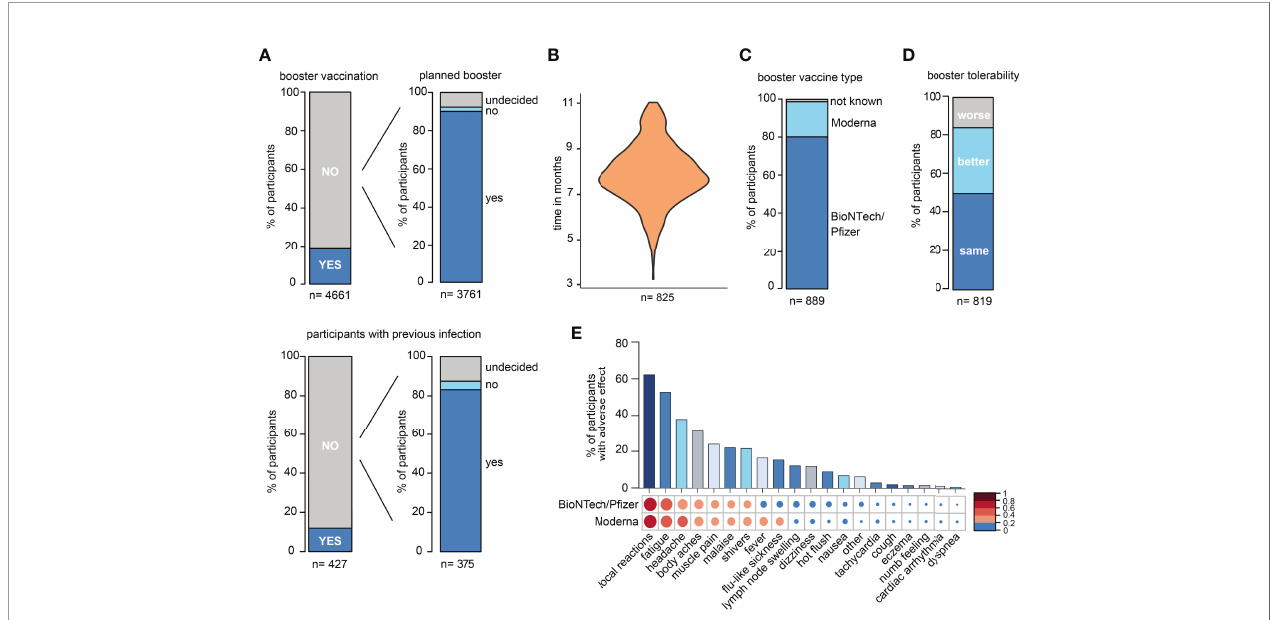
FIGURE 1 | Survey data from the DigiHero SARS-CoV-2 booster vaccination module. (A) Statistics of participants with prior or planned third SARS-CoV-2 vaccination (booster). (B) Time between completion of the primary vaccination series and third vaccination in months. (C) SARS-CoV-2 third vaccination type. (D) Tolerability of the third vaccination compared to previous SARS-CoV-2 vaccinations. (E) Adverse events upon third